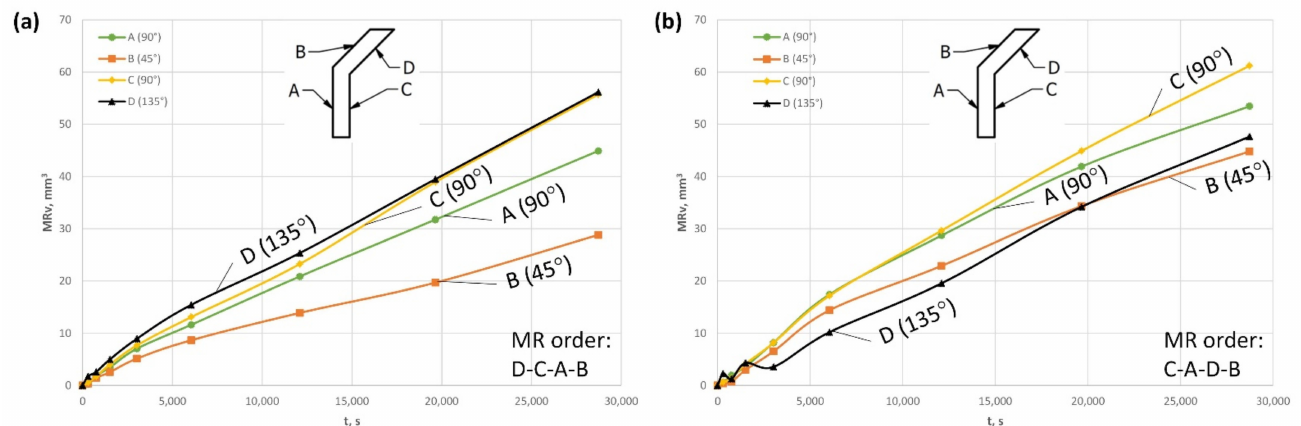
Figure 14. Average MR ( t ) on surfaces A, B, C, D of the ( a ) pre-polished and ( b ) as-built V-shape artifacts (average